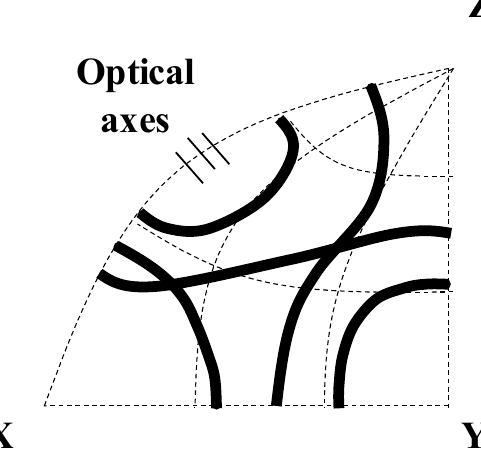
Figure 5. BPM Topologies of biaxial media, which are also possible topologies for AQPM. The three lines crossing the xz-plane stand for the optical axes at the wavelengths of the three interacting waves.